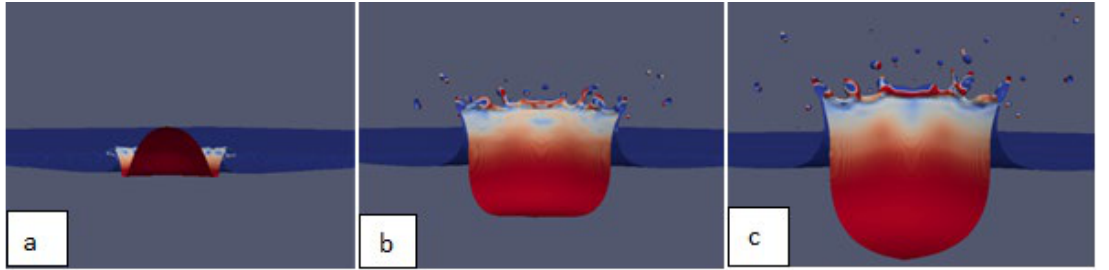
Figure 13. Visualisation of selected times of the 3D simulation of the multiphase splash phenome- non, depicted from the drop impact centre: ( a ) 0.7 ms; ( b ) 1.8 ms; ( c ) 3.2 ms time. depicted from the drop impact centre: ( a ) 0.7 ms; ( b ) 1.8 ms; ( c ) 3.2 ms